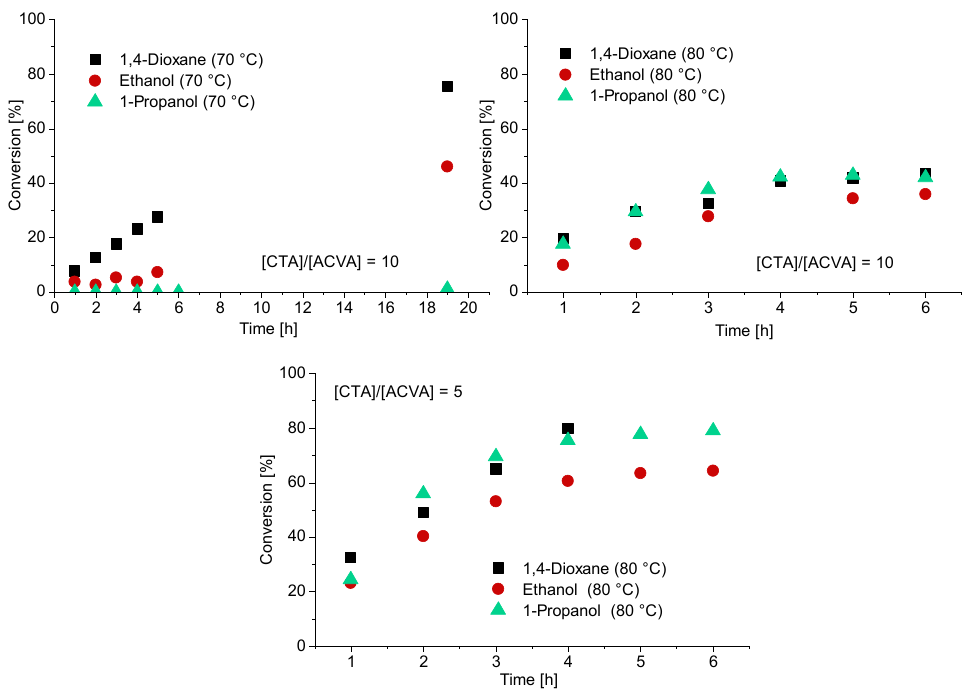
Figure 4. Reaction time versus conversion of the RAFT polymerization of PMAA with CTA3 and a targeted DP of [MAA]/[CTA3] = 120 and a molar ratio of [CTA3]/[ACVA] = 10. For the polymerizations at 80 °C a kinetical study with a molar ratio of [CTA3]/[ACVA] = 10 and 5 is displayed.